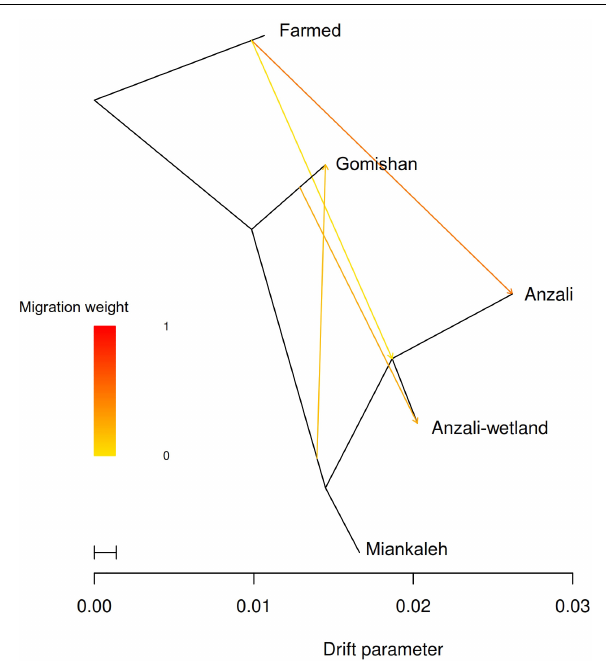
FIGURE 6 | Graph of admixture between 117 individuals of C. carpio fitted using TreeMix (Pickrell and Pritchard, 2012) with three migration edges. The drift parameter is proportional to 2Ne (effective population size) generations and migration weight indicates the proportion of ancestry deriving from the migration edge.